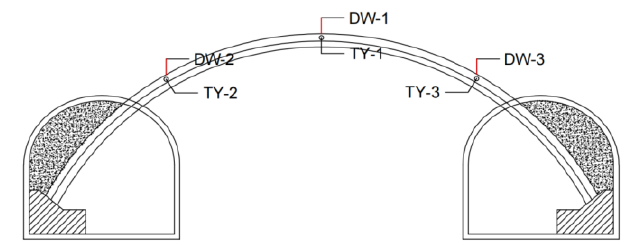
Figure 6. Automated sensor placement location